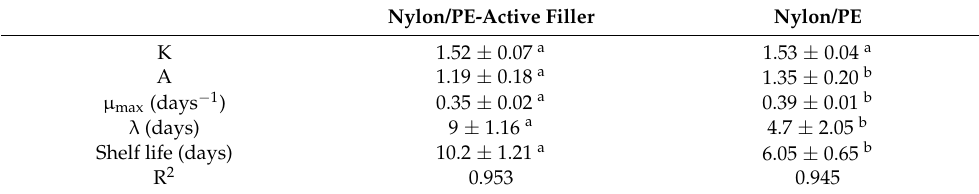
Table 4. Parameters derived from Equation